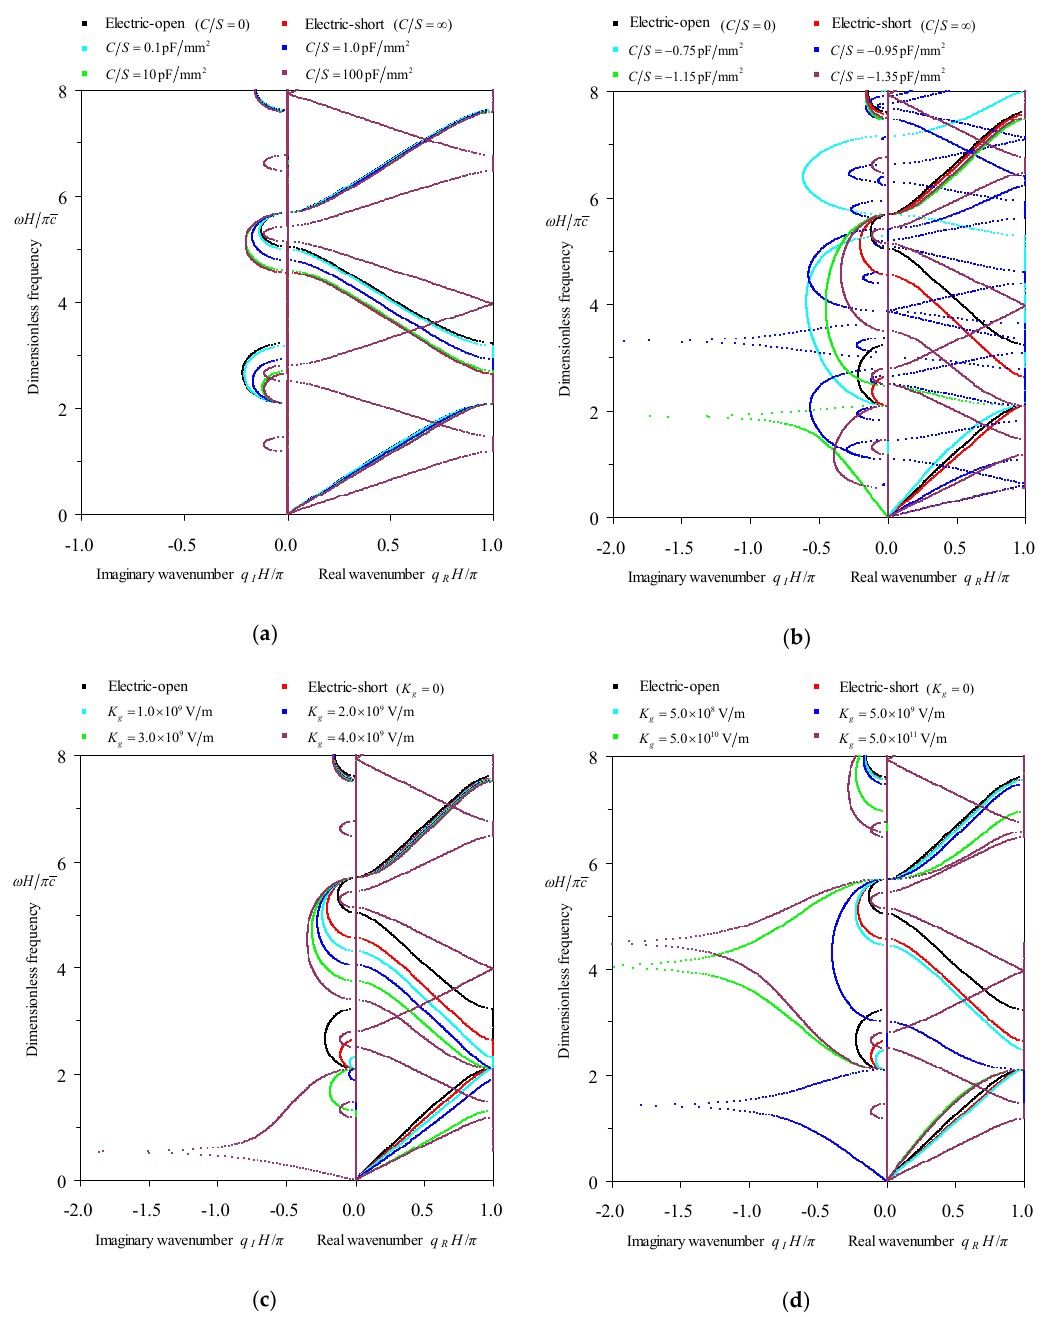
Figure 5. The effects of the electrical boundaries on the wavenumber spectra of elastic waves in periodic Glass-Brass-(PZT-5H 1 )-Brass multilayers: ( a ) Applied positive capacitance; ( b ) Applied negative capacitance; ( c ) ( d ) Applied feedback control.